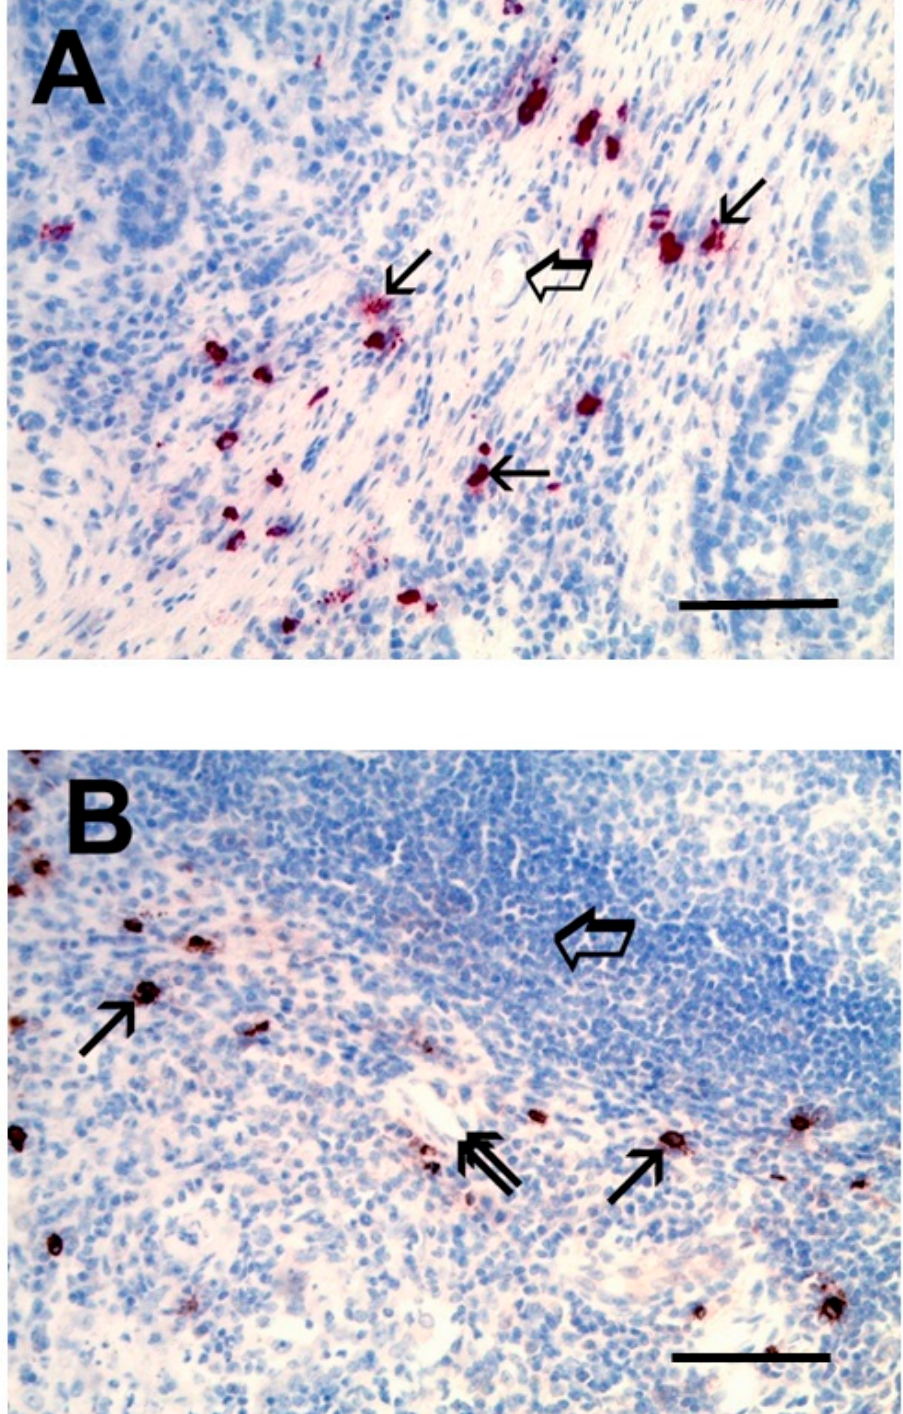
Figure 2. ( A ) Primary gastric cancer tissue immunostained with an anti-tryptase antibody demonstrates the presence of several mast cells in red (single arrow). Big arrow indicates a blood vessel with a red blood cell in its lumen (40 × ). ( B ) Metastatic lymph node from primary gastric cancer immunostained with an anti-tryptase antibody. Single arrows indicate red stained mast cells; the big arrow indicates a lymphocyte and the double arrow indicates a blood vessel (40 × ). Reprinted from Ammendola et al. (Int. J. Mol. Sci. 17: E1905, 2016). Bars: A and B = 100 µ